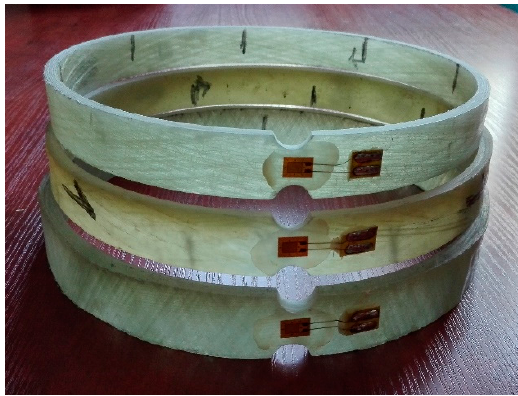
Figure 8. Samples cut from pipes with winding angles of glass fibers θ = 85° (highest), θ = 55° (middle) and θ = 20° (lowest) to test the peripheral tensile strength and modulus of elasticity.